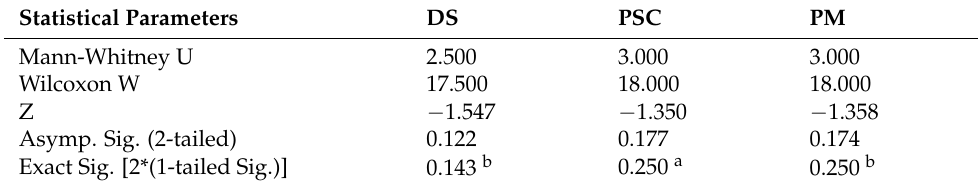
Table 7. Project consultants on impact of Industry 4.0 tools in quality management